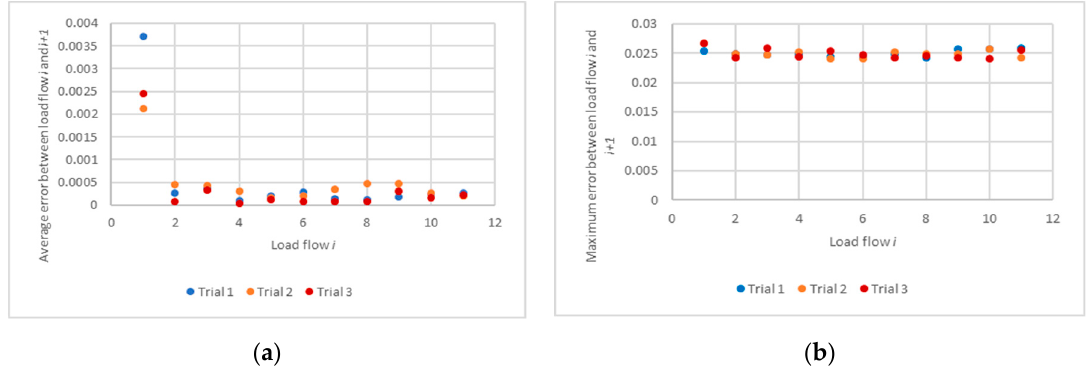
Figure 9. Metrics measured for Case 1.2. ( a ) Average error Δ(cid:3365) of the secondary voltages between the results of consecutive power flows. ( b ) Maximum absolute error Δ (cid:3040)(cid:3028)(cid:3051) of the secondary voltages between the results of consecutive power flows.